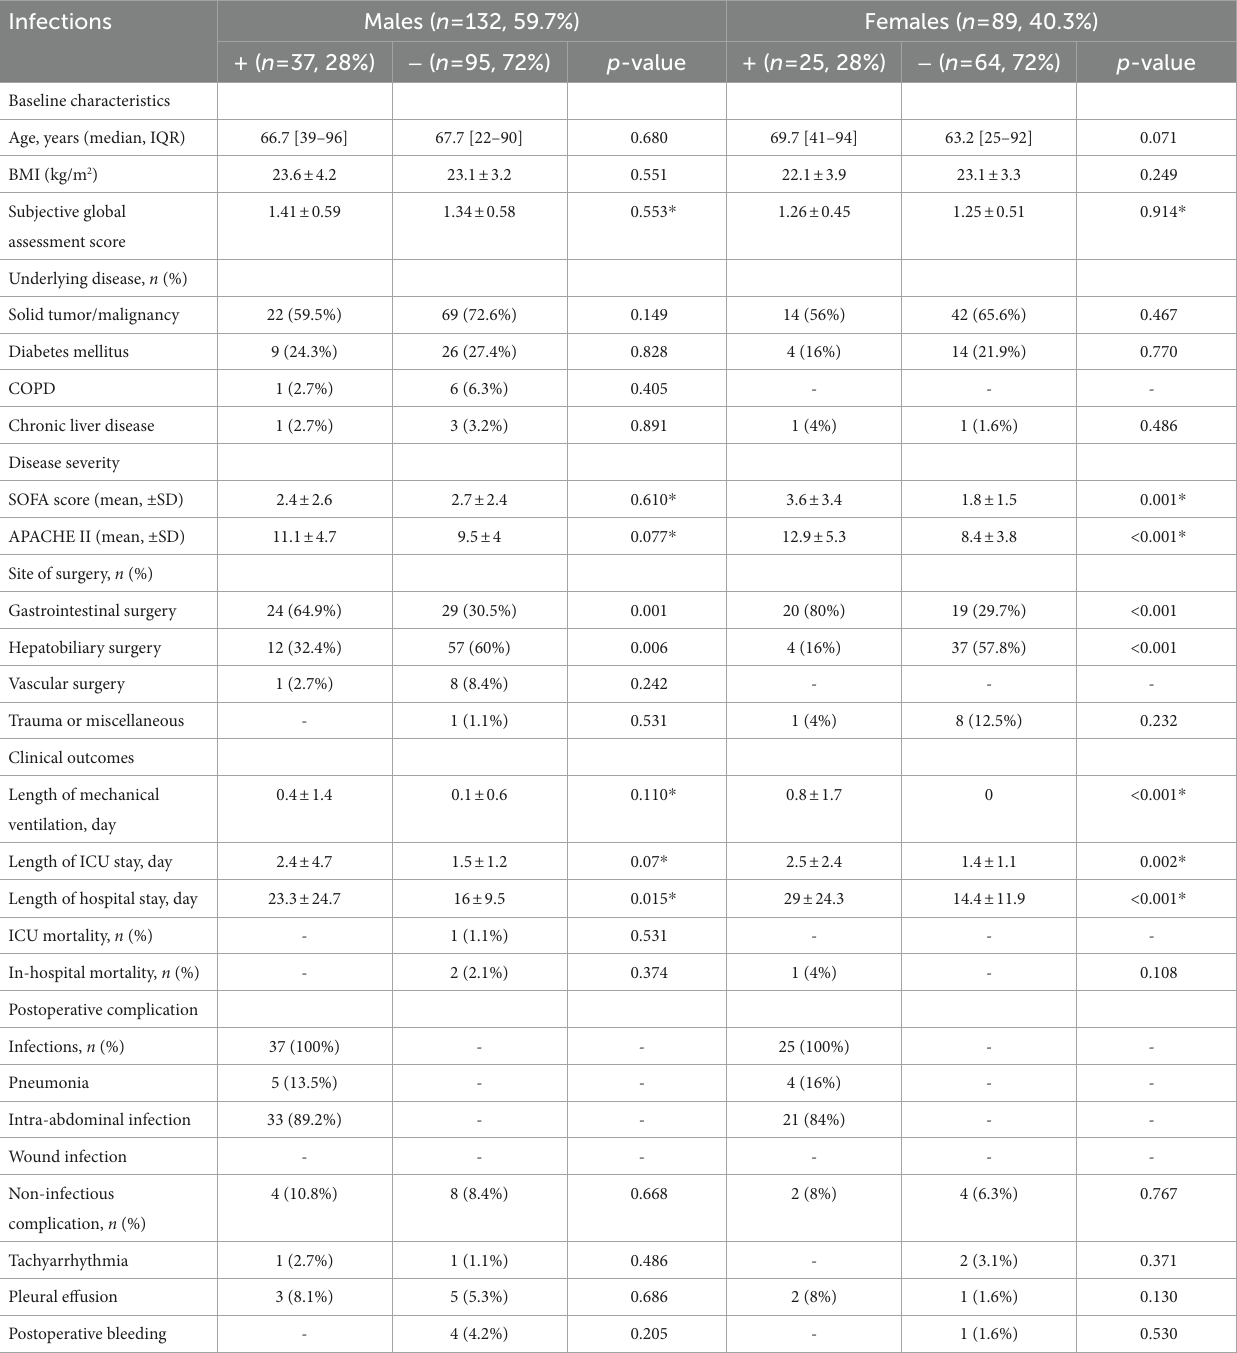
TABLE 1 Comparative analysis of demographic characteristics and clinical outcomes between two groups according to occurrence the infection after surgery by dividing into males and females.